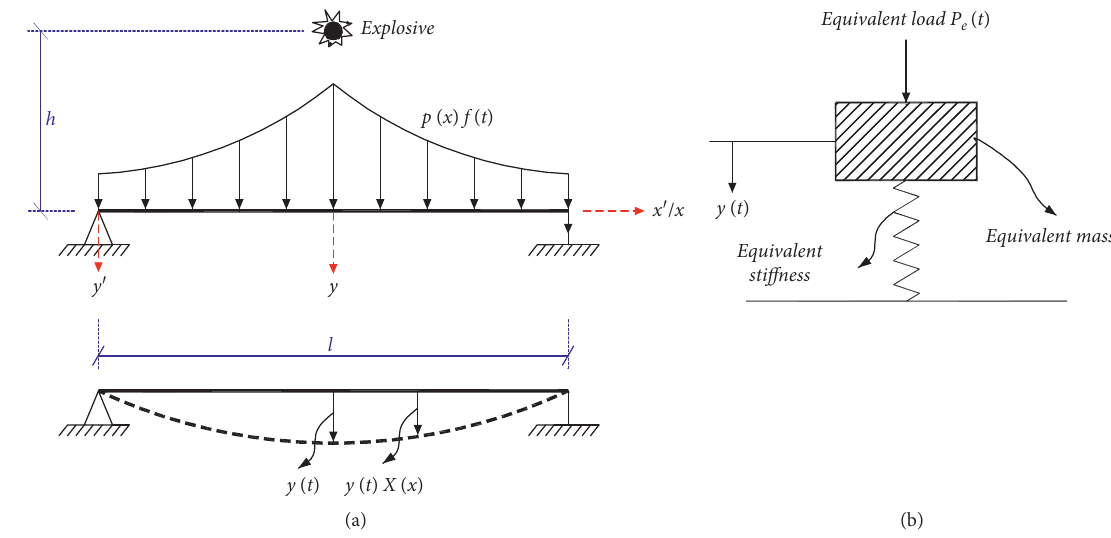
Figure 1: (a) Real structural system; (b) equivalent SDOF